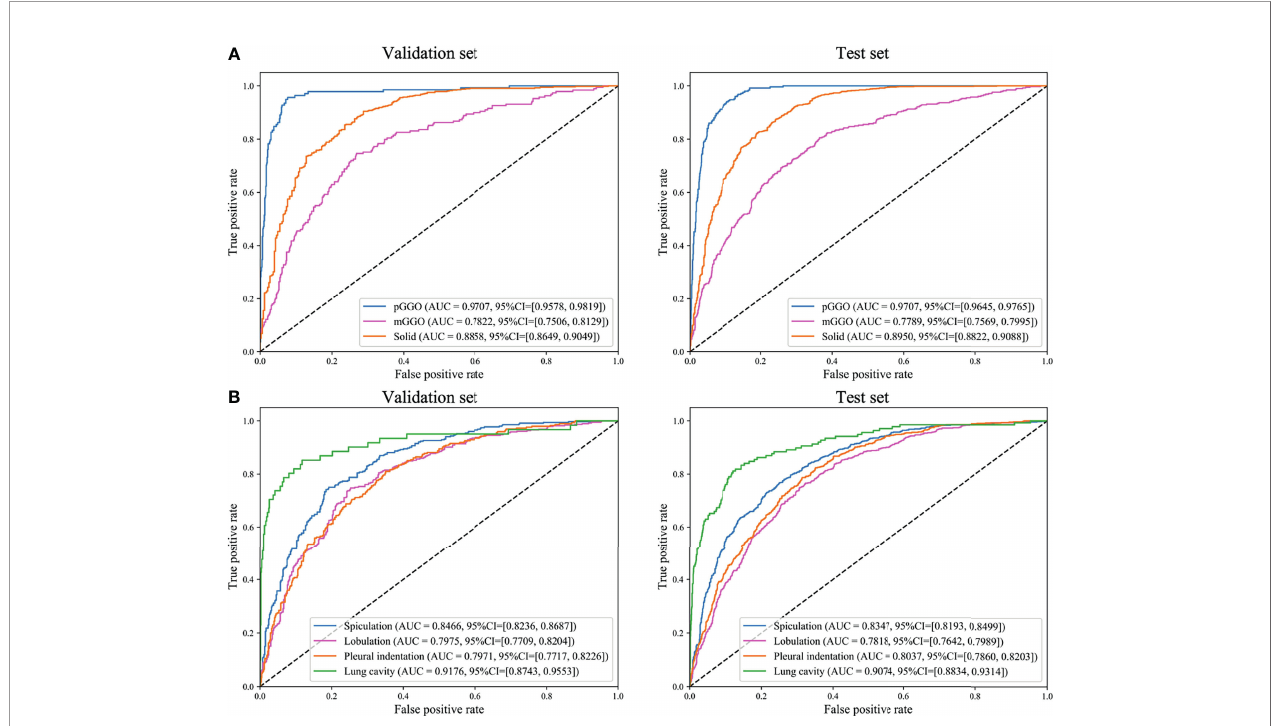
FIGURE 3 | Receiver operating characteristics (ROC) curves of DeepLN to identify, (A) density, (B) morphology of nodules. AUC, area under curve; pGGO, pure- ground glass opacity; mGGO, mixed-ground glass